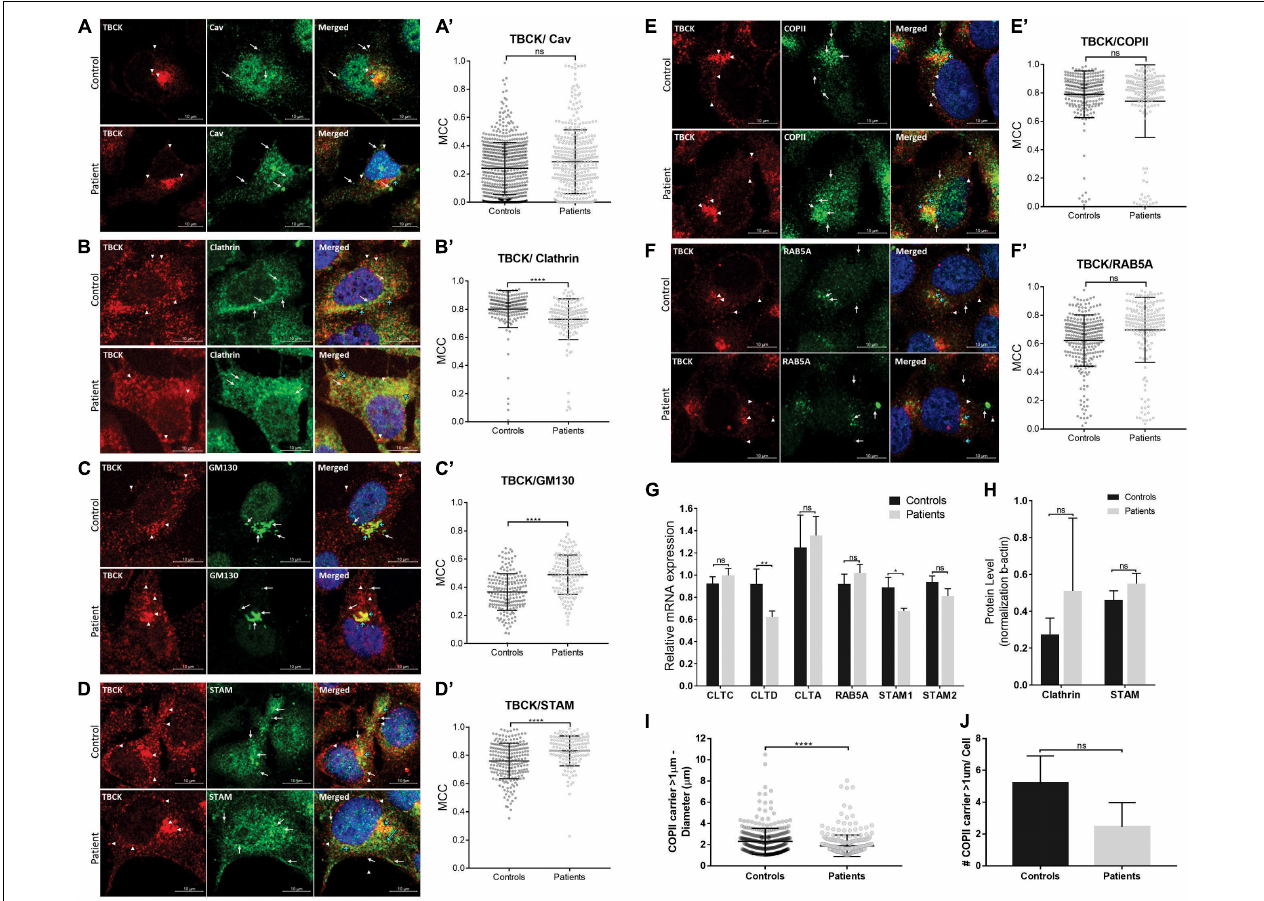
FIGURE 3 | Patient-derived iNPC show altered colocalization levels with endocytic and early secretory pathway markers. (A–F) Representative images of confocal microscopy of iNPC coimmunostained for endogenous TBCK and specific vesicle transport machinery components: (A) Caveolin (Cav), (B) Clathrin, (C) GM130/GOLGA2, (D) STAM, (E) COPII, and (F) RAB5A. For more detailed images, see Supplementary Figure 5 . White arrowheads indicate TBCK dots; white arrows indicate the vesicle transport regulators indicated on each image; blue arrows indicate the colocalized dots. (A (cid:48) –F (cid:48) ) Graphs of Manders coefficient colocalization (MCC) of TBCK with each target protein. Measurements were performed using ImageJ/Fiji-Coloc2 plugin. Error bars indicate SD (each dot represents the MCC in each cell; data represent the analysis of n > 150 cells/individual). (G) Relative mRNA expression of vesicle transport regulators in iNPC grown as neurospheres show reduced clathrin heavy chain CLTD and STAM1 transcript levels in neurospheres of patients, compared with neurospheres of controls. (H) Clathrin and STAM immunoblot densitometries reveal a tendency to increase protein levels in neurospheres of patients, compared with neurospheres of controls. (I,J) Analysis of large COPII carrier ( > 1 µ m) average diameter (I) and number per cell (J) . **** p -value < 0.0001. Unpaired t -test, two-tailed. Data are shown as mean ± SD of biological replicates. 4 (cid:48) ,6-diamidino-2-phenylindole (DAPI) (blue) marks cell nuclei. Scale bar = 10 µ M. Patients: F6331-1 and F6331-4 ( N = 2); controls: F7007-1, F8799-1, and F10006-1 ( N = 3). * p -value < 0.05, ** p -value < 0.01, ns - not